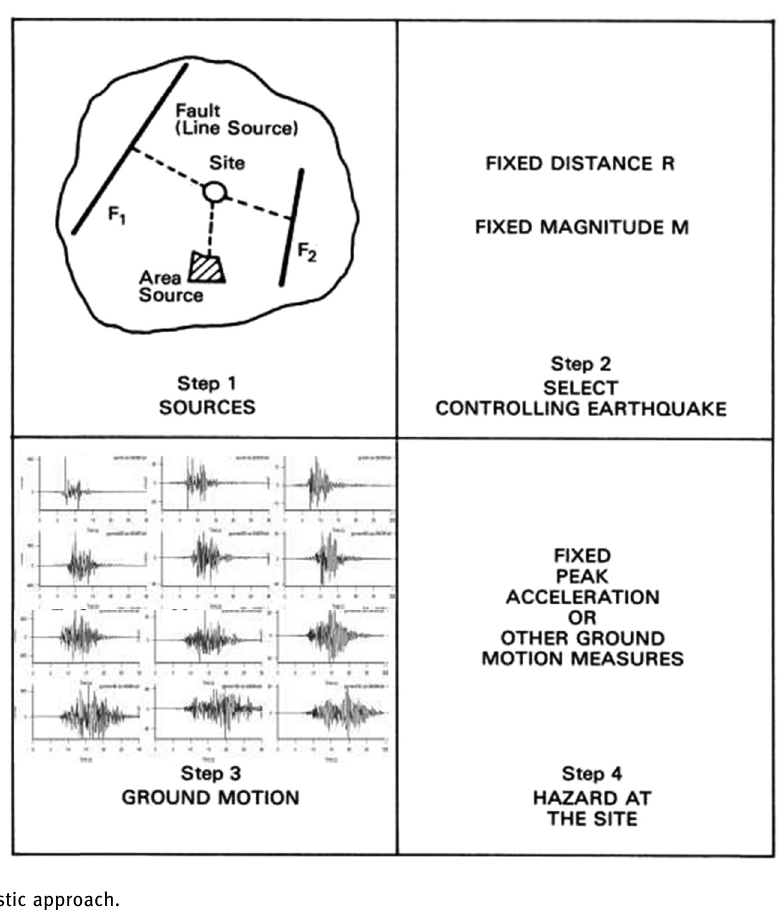
Figure 1: Neo - deterministic approach.